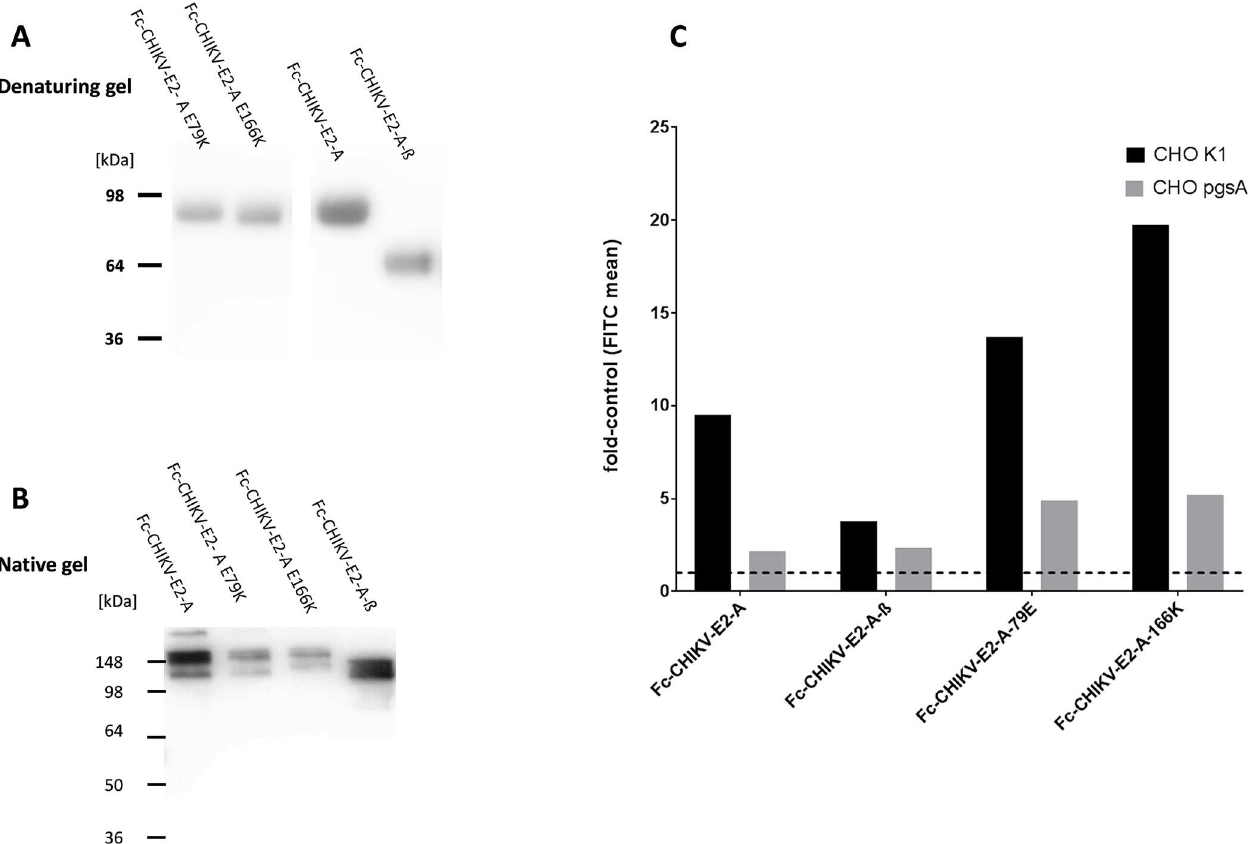
Fig 8. Binding of Fc-fusion proteins containing variants of the CHIKV E2 domain A to CHO-K1 and pgsA-745 cells. A: Fc-E2 domain A- fusion proteins and Fc protein were expressedfrom HEK293T cells, affinity purifiedby protein-Achromatography and separatedby SDS-PAGE. The Western blot was detected with an HRP-labeled anti-humanIgG antibody. The calculatedmolecularweights are: Fc-CHIKV-E2-A, E79K and E166K 53 kDa; Fc-CHIKV-E2-A-ß 43,4 kDa. B: Separationof the Fc-fusion proteinsunder native conditions. The Western blot was detected with an HRP-labeled anti-human IgG antibody. C: CHO-K1 (black) and pgsA-745 (grey) cells were incubatedwith the indicatedrecombinant Fc-fusion proteins. Bindingwas measuredby flow cytometry using an anti-humanIgG FITC conjugated antibody.The results are shown as fold induction comparedto Fc binding.A value of one represents the mean FITC value of the control and is labeledby the dashedline. Values abovethis line indicatebinding.Data represent an averageexperiment of three independent experiments performed.